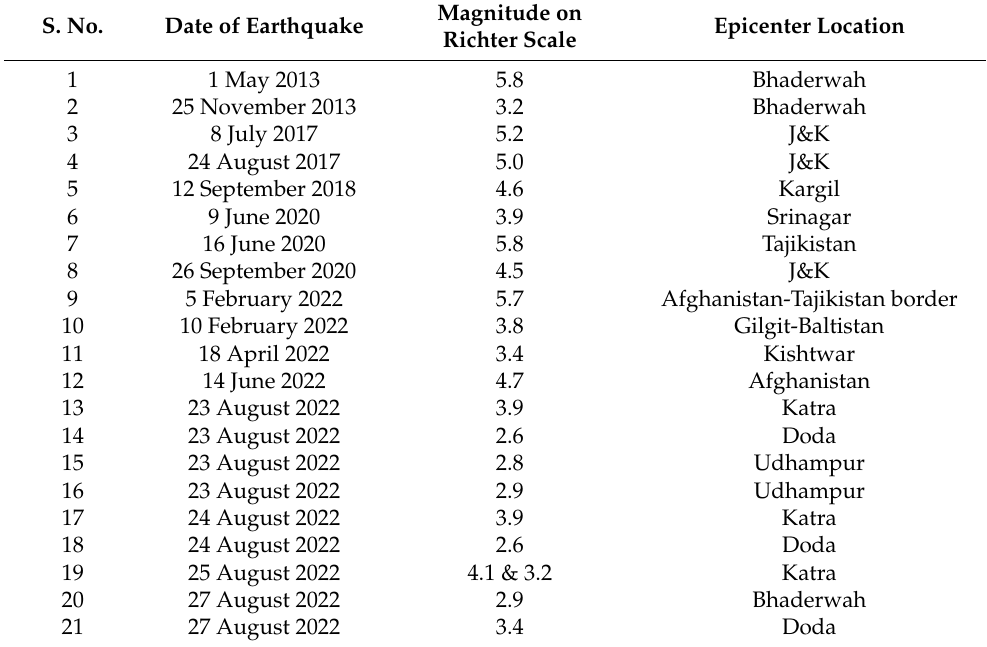
Figure 9. ( a ) Massive landslide blocks Jammu’s circular road adapted from source: Ref [67,68], ( b ) Landslide on Jammu Srinagar national Highway adapted from source: Ref [69].